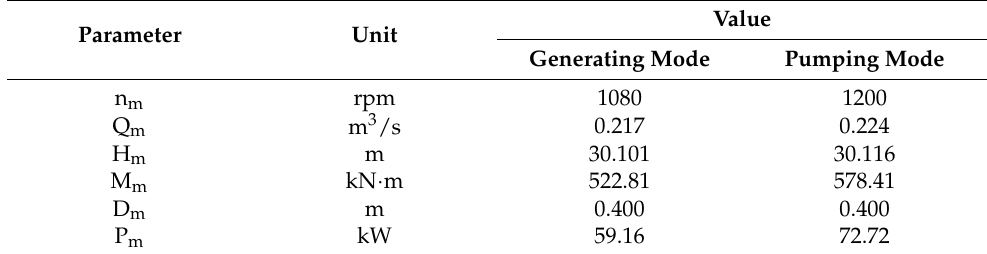
Table 2. Model characteristics of the pump-turbine.